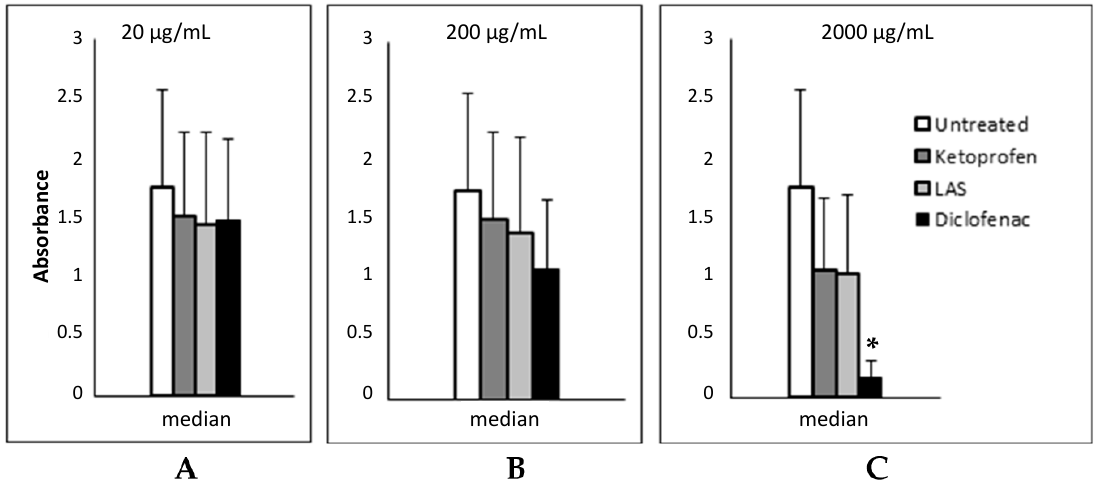
Figure 3. Absorbance values of untreated and exposed cells at concentration of 20 µg/mL ( A ), 200 µg/mL ( B ) and 2000 µg/mL ( C ), respectively. *, p = 0.0000, Kruskal–Wallis test.